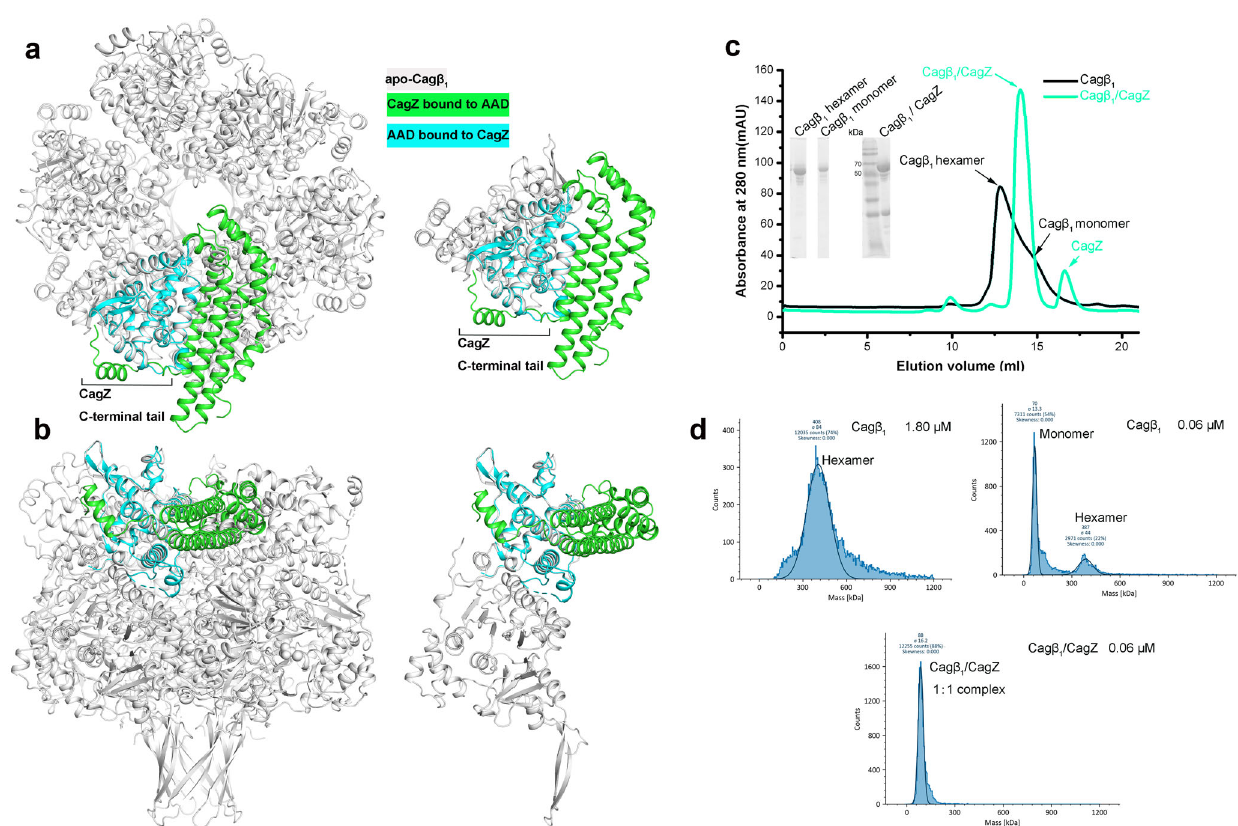
Fig. 5 | CagZ traps Cag β in the monomeric state. a , b Structure superimposition of the Cag β -AAD 1 /CagZ complex with the apo-Cag β hexamer or one apo-Cag β protomer. CagZ bound to one Cag β protomer clashes severely with the neigh- boring Cag β protomer, supporting the notion that this binding is not compatible with the Cag β hexameric assembly. c Size exclusion chromatography analyses of puri fi ed Cag β 1 (75 µ M, black) and the Cag β 1 /CagZ complex (110 µ M, green). The inset demonstrates the purity of proteins used in experiments (Uncropped SDS- PAGE is provided in the Source Data fi le). d Mass distribution of Cag β 1 and the